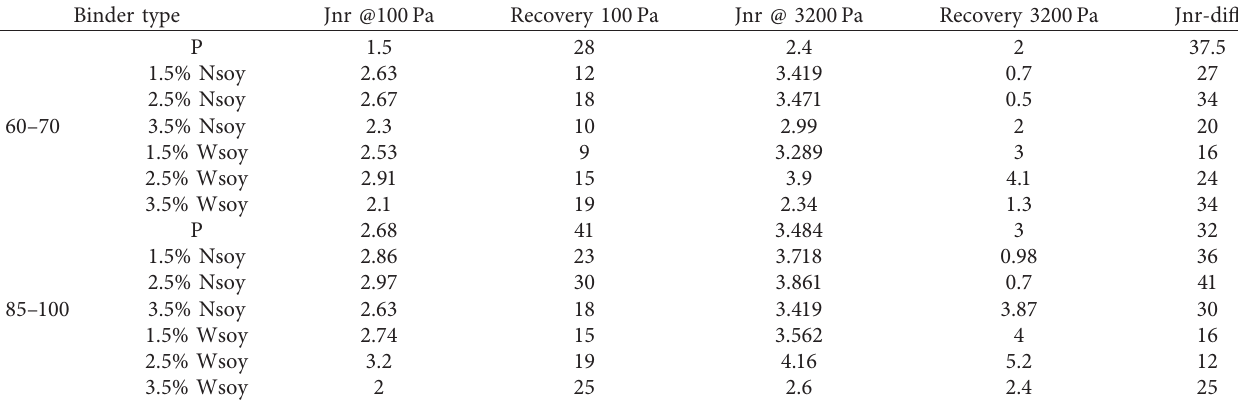
Table 8: MSCR outcomes of unmodified and modified binders.